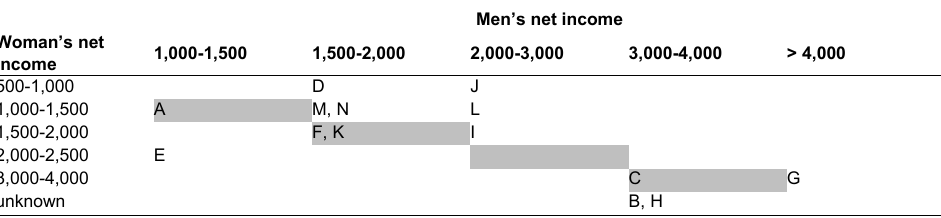
Table 3 : Net income (in euro) at the couple level at the time of the first